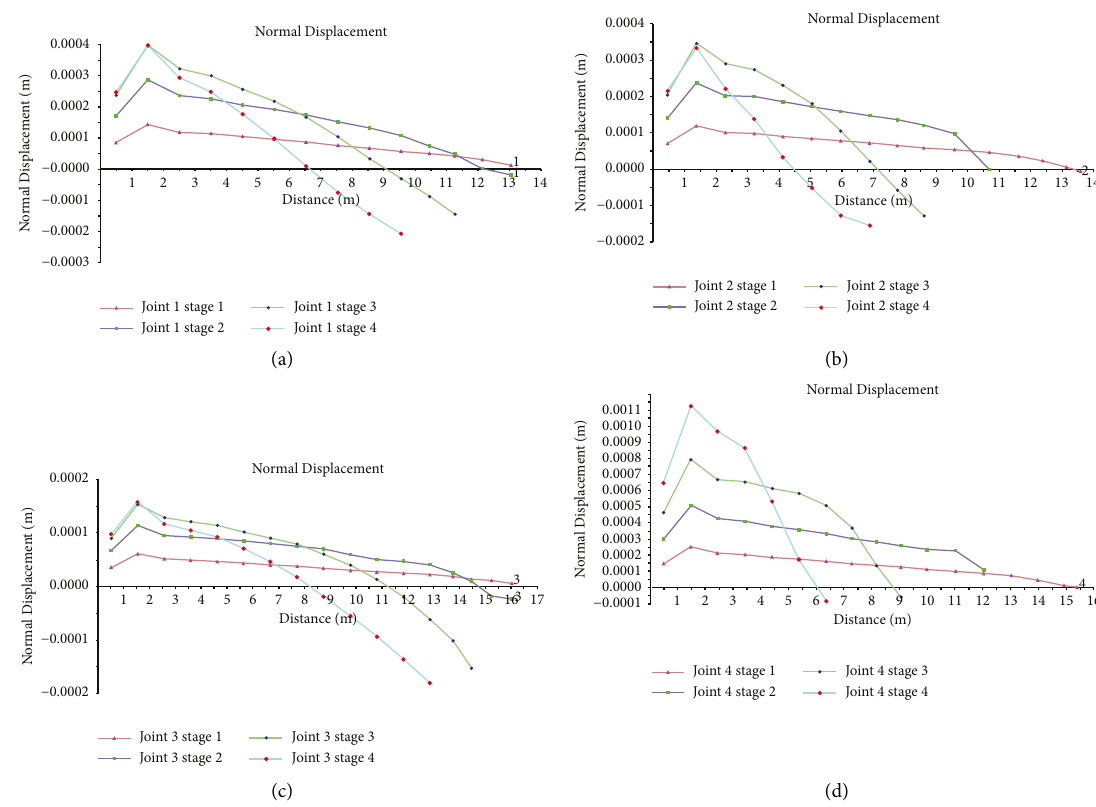
Figure 9: Normal displacements caused by (a) joint 1, (b) joint 2, (c) joint 3, and (d) joint 4 along the